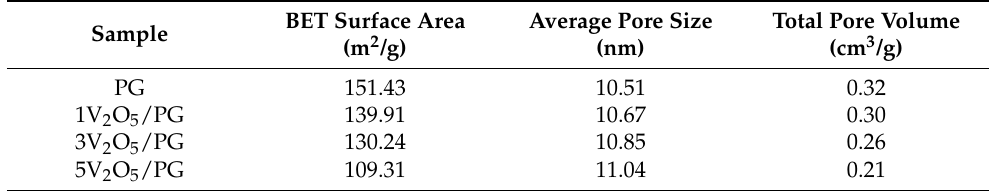
Table 1. Properties of the PG and V 2 O 5 /PG catalysts.